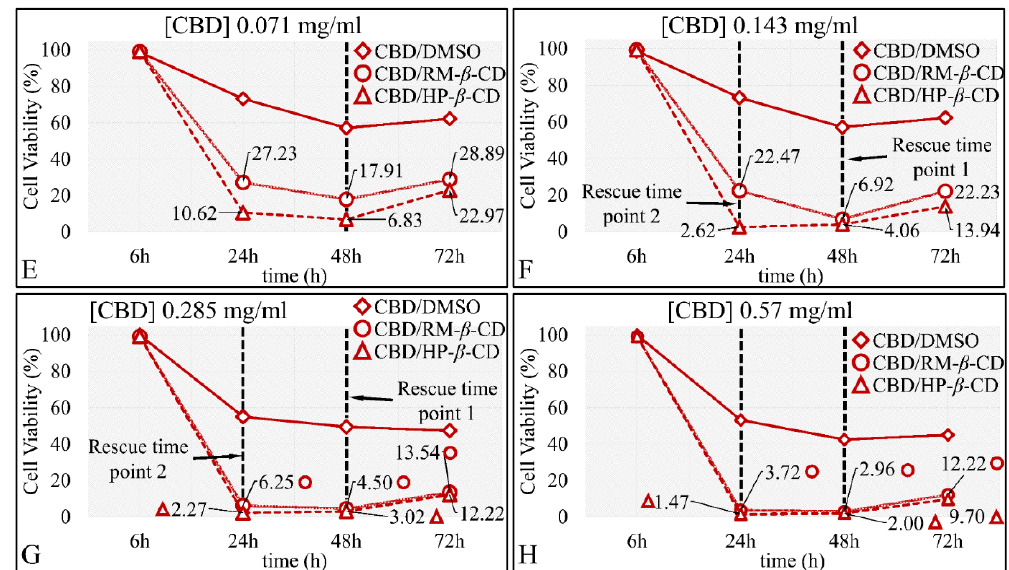
Figure 9. Comparative effectiveness of CBD and CBD inclusion complexes on A172 cells, with respect to time in particular, the concentrations 0.0045 mg/mL ( A ), 0.009 mg/mL ( B ), 0.018 mg/mL ( C ), 0.036 mg/mL ( D ), 0.071 mg/mL ( E ), 0.143 mg/mL ( F ), 0.285 mg/mL ( G ), and 0.57 mg/mL ( H ) are presented. The most effective inclusion complexes were the CBD/HP- β -CD and CBD/RM- β -CD in all concentrations between the 24 and 72 h cytotoxicity ( p < 0.0001), followed by CBD/DMSO. Each value represents the mean ± SD of triplicate experiments.